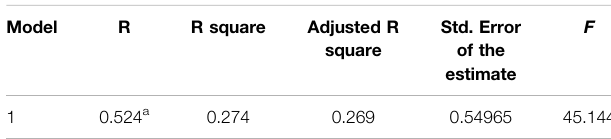
TABLE 7 | Case C: H2. Regression model summary.